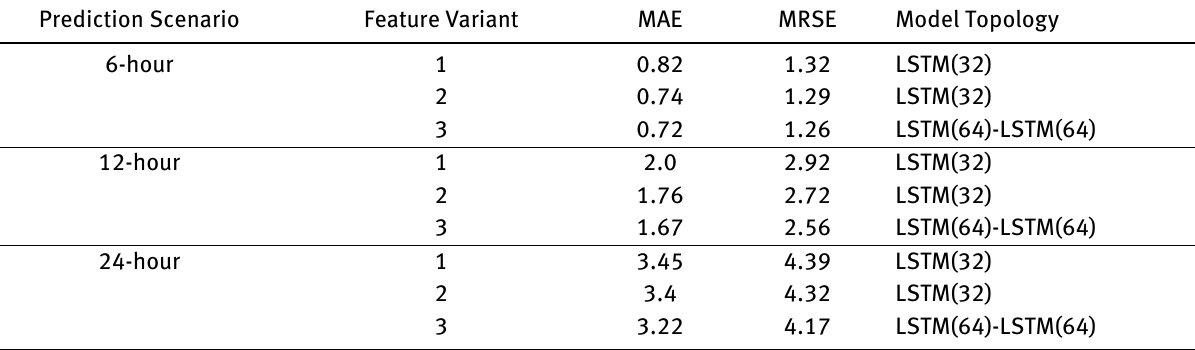
Table 1: Evaluation results for different prediction scenarios and feature variants. Prediction